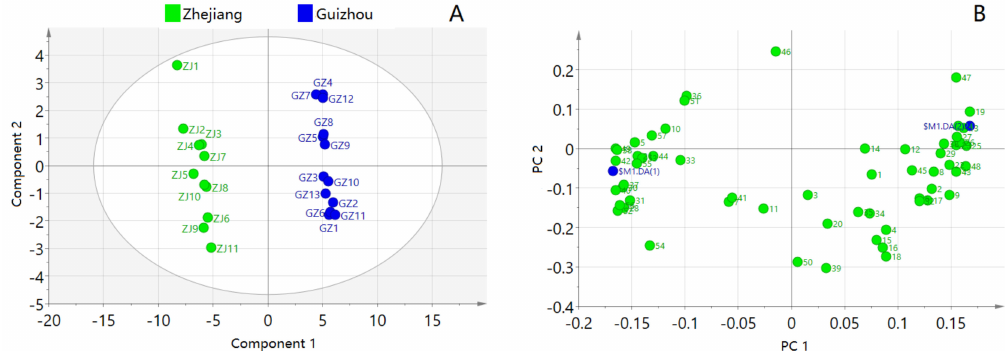
Figure 3. Score plot ( A ) and loading plot ( B ) of principal component analysis of 24 samples of Selaginella doederleinii from two